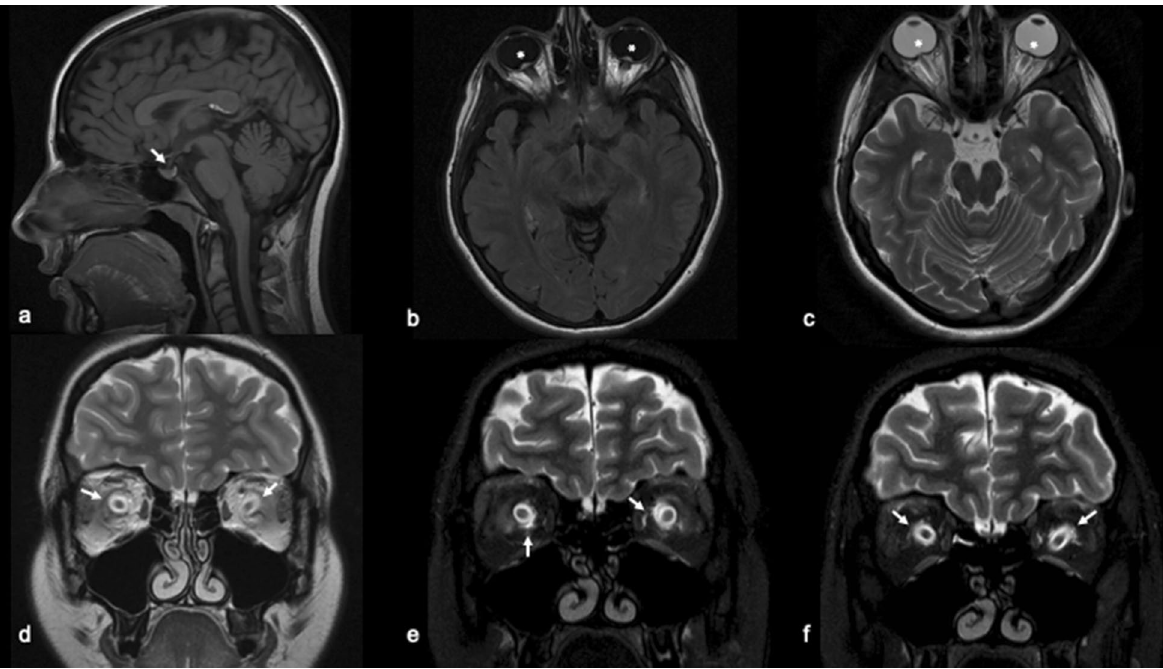
Fig. 1 A 15-year-old female with a 2-week history of occipital headache and cervical pain, later accompanied with nausea, vomiting, diplopia, blurred vision and tinnitus in her right ear. MR, sagittal T1WI a revealed a small pituitary gland for the age group with superior concavity (arrow), presumably secondary to the raised intracranial pressure. Axial FLAIR ( b ) and axial T2WI c showed flattening of the posterior contour of the eye globes with apparent protrusion/swelling of the optic discs (asterisks). In coronal T2WI d an enlargement of the optic nerve/sheath complex (arrows) was denoted and confirmed by the coronal T2WI FatSat e , f in which the enlargement was conspicuous in more than one slice and surrounded by a high signal of the perineural fat related to transudation of CSF (arrows)